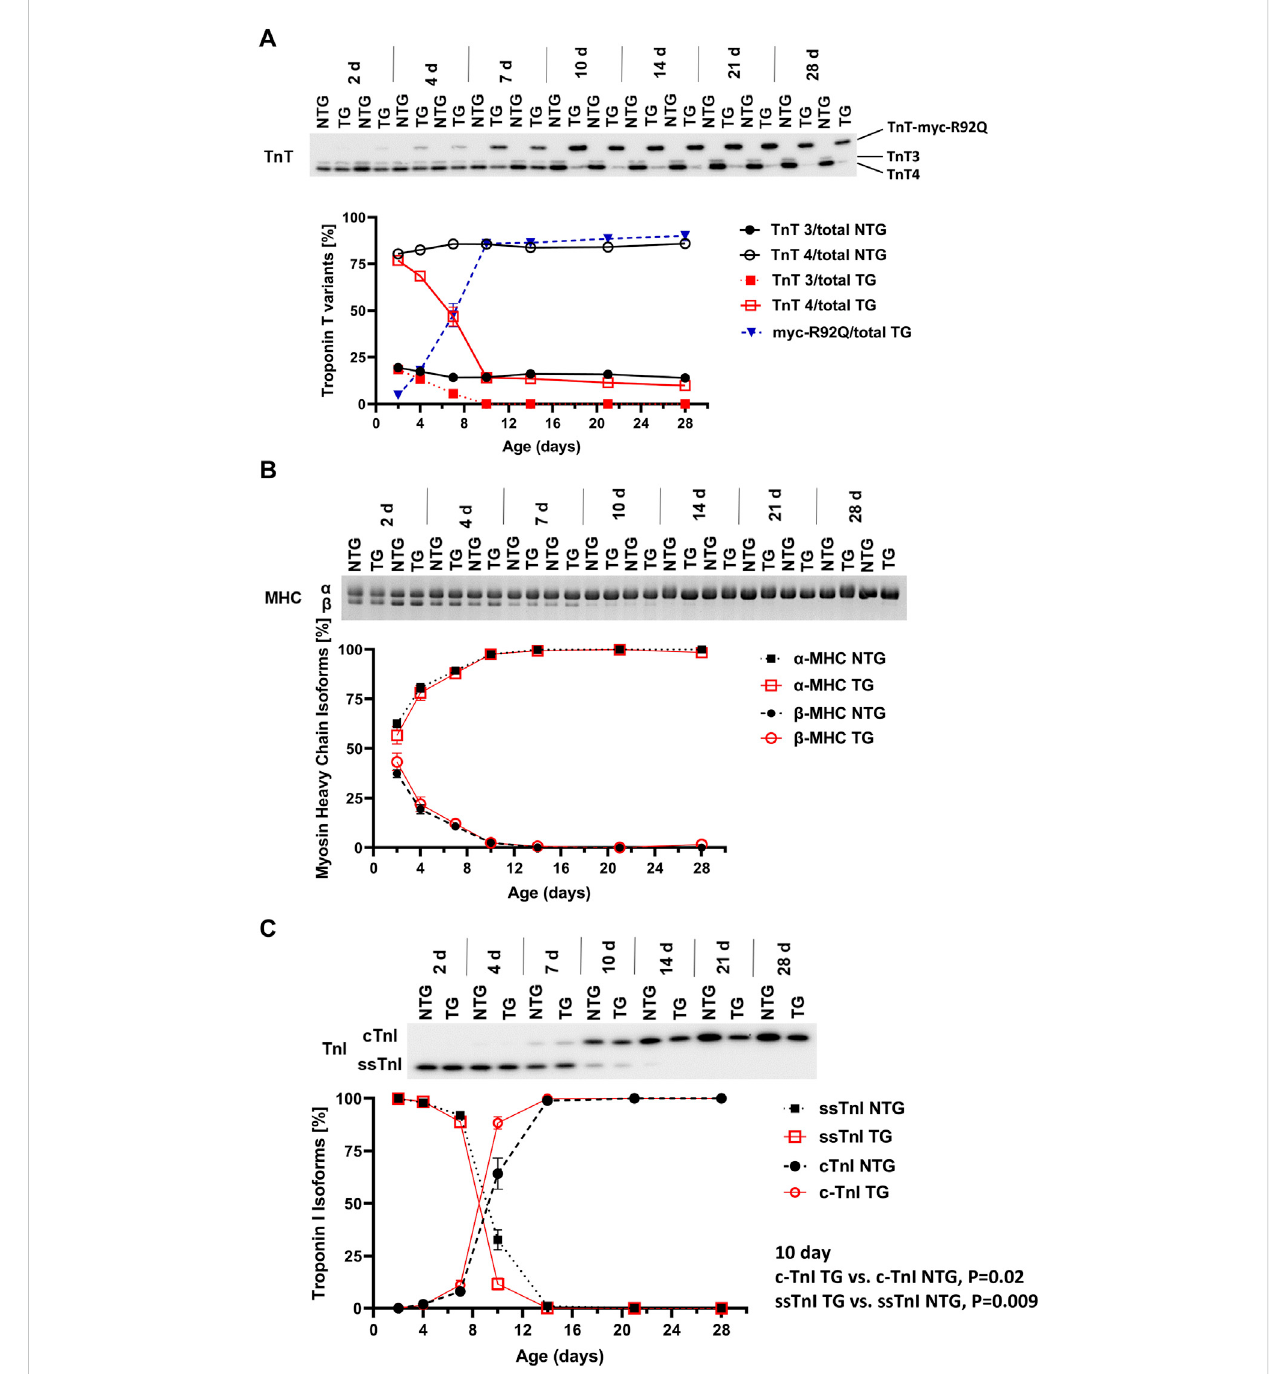
FIGURE 2 Timeline of myo fi lament isoform switches. Representative images of Western blots and SDS-PAGE summary data of expression of (A) troponin T (TnT)isoforms (N=2for bothgroups), (B) myosinheavychain(MHC) isoforms,and (C) troponinI(TnI)isoformsinNTGandTGheartsfromP2toP28. For (B,C) N = 4 for both groups. Data are presented as mean ± SEM. NTG, non-transgenic; TG, transgenic. TnT3 — adult splicing form 3 of Troponin T; TnT4 — adult splicing form 4 of Troponin T; myc-R92Q, myc tag for TnT-R92Q mutation; ssTnI, slow skeletal isoform of TnI; cTnI, cardiac isoform of